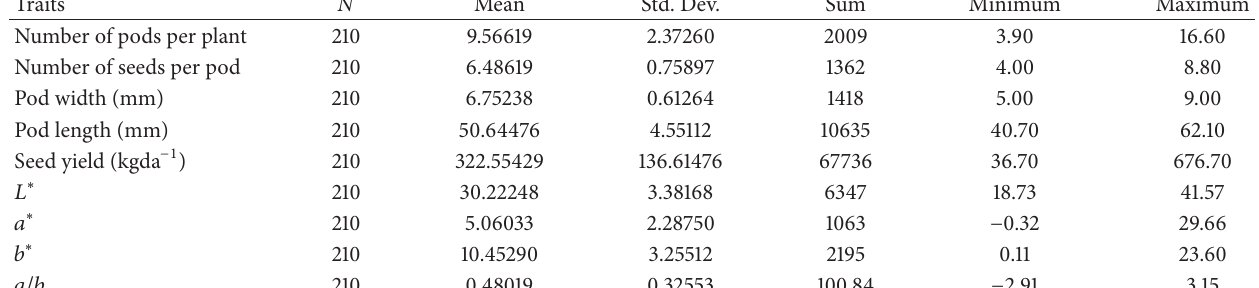
Table 2: Average minimum and maximum numbers of pods per plant, the number of seeds per pod, pod dimension (width and length), seed yield, and the colour parameters ( 𝐿 ∗ , 𝑎 ∗ , and 𝑏 ∗ ) of 70 common vetch lines and cultivars.